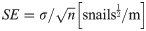
Quadrat sampling scheme performance.Reported are the distribution of standard errors (SE=σ/n[snails12/m]), relative standard errors (SE/μ [-]), the index of dispersion (ID = σ2/μ [-]) and the mean density (μ [snails/m2]) by habitat and intermediate host species.